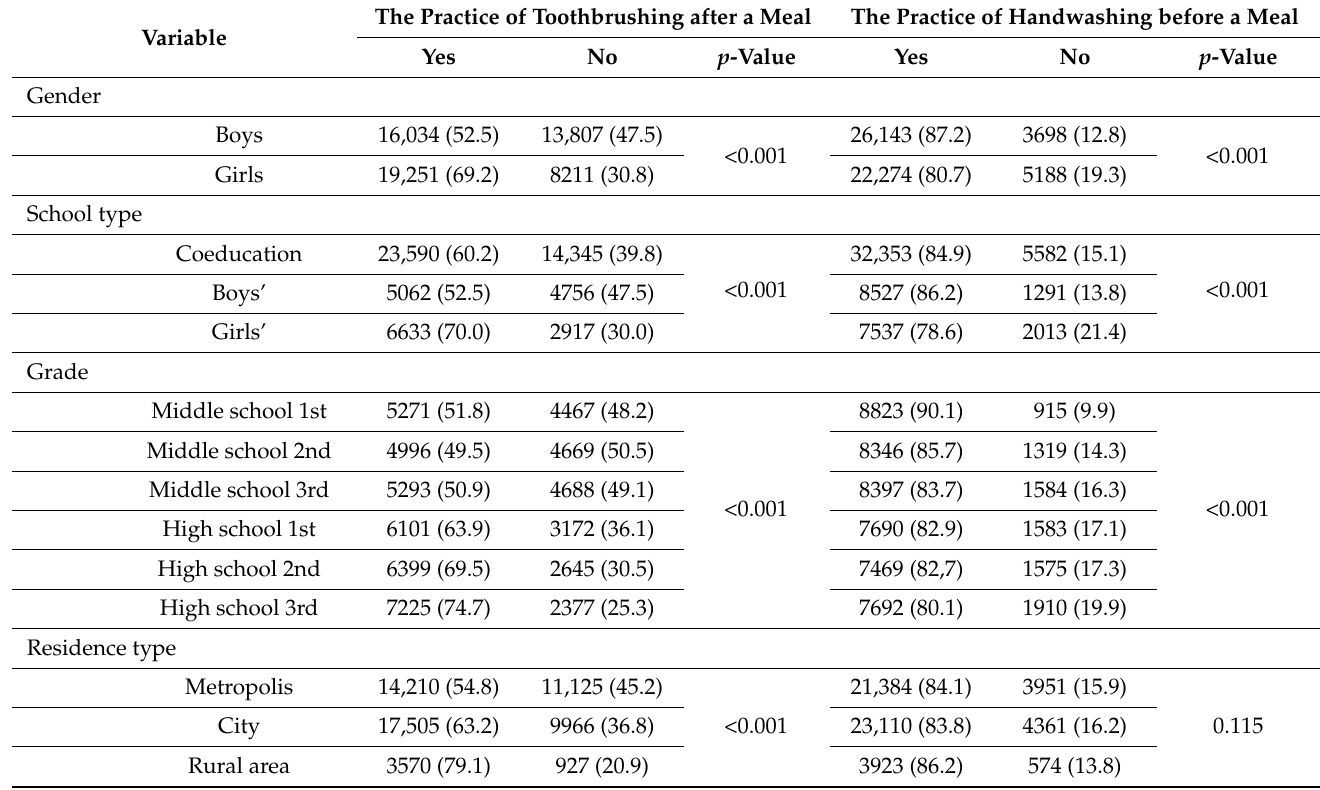
Table 2. Toothbrushing and handwashing practice data stratified by the general characteristics of the subjects ( n = 57,303).